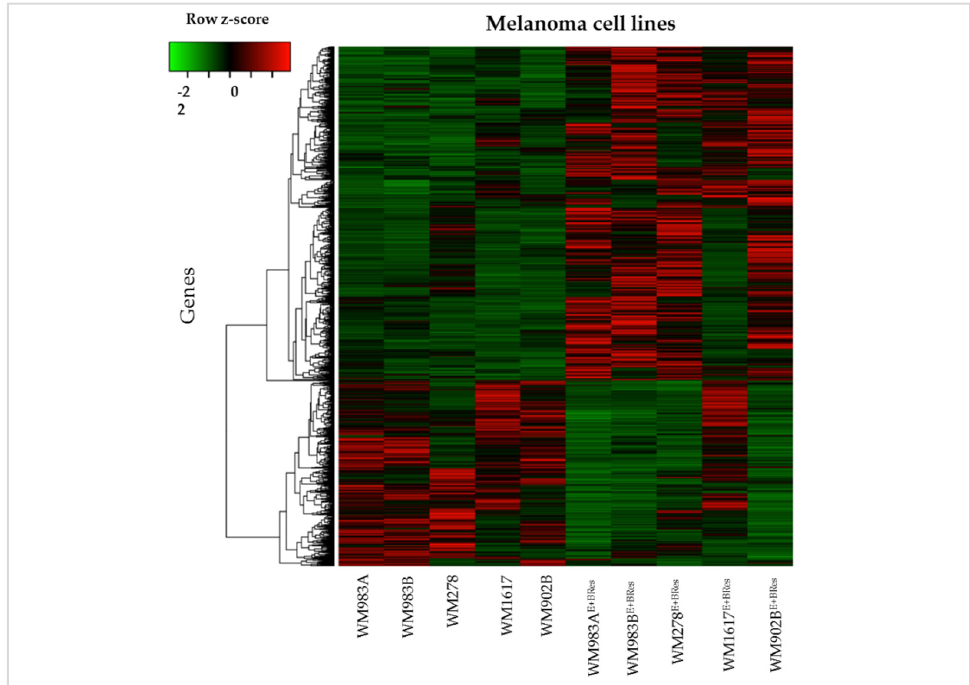
Figure 8. Unsupervised hierarchical clustering of the 1591 differentially expressed genes in BRAFi/MEKi-sensitive and -resistant melanoma cell lines. Cell lines are displayed vertically, and genes are displayed horizontally. The colour of each cell represents the median-adjusted expression value of each gene. Red represents increased gene expression, and green represents decreased gene expression. Table 3. Gene sets correlated with the resistant phenotype.